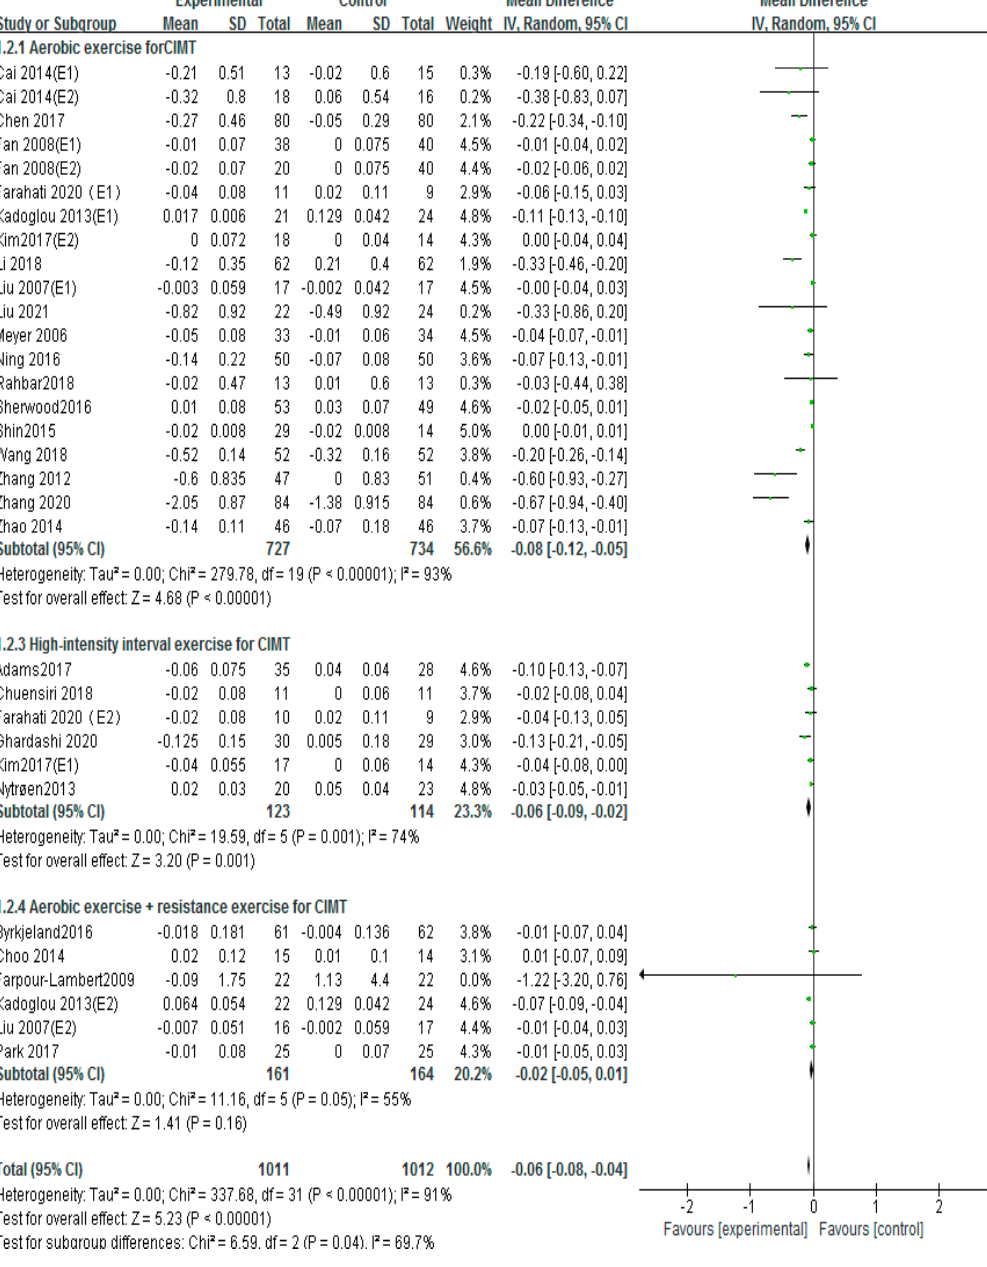
Figure 5. Subgroup analysis of cIMT effect size under different modes of exercise [12–15,17–20,22,23,26–31,33–35,37–41,43,44].